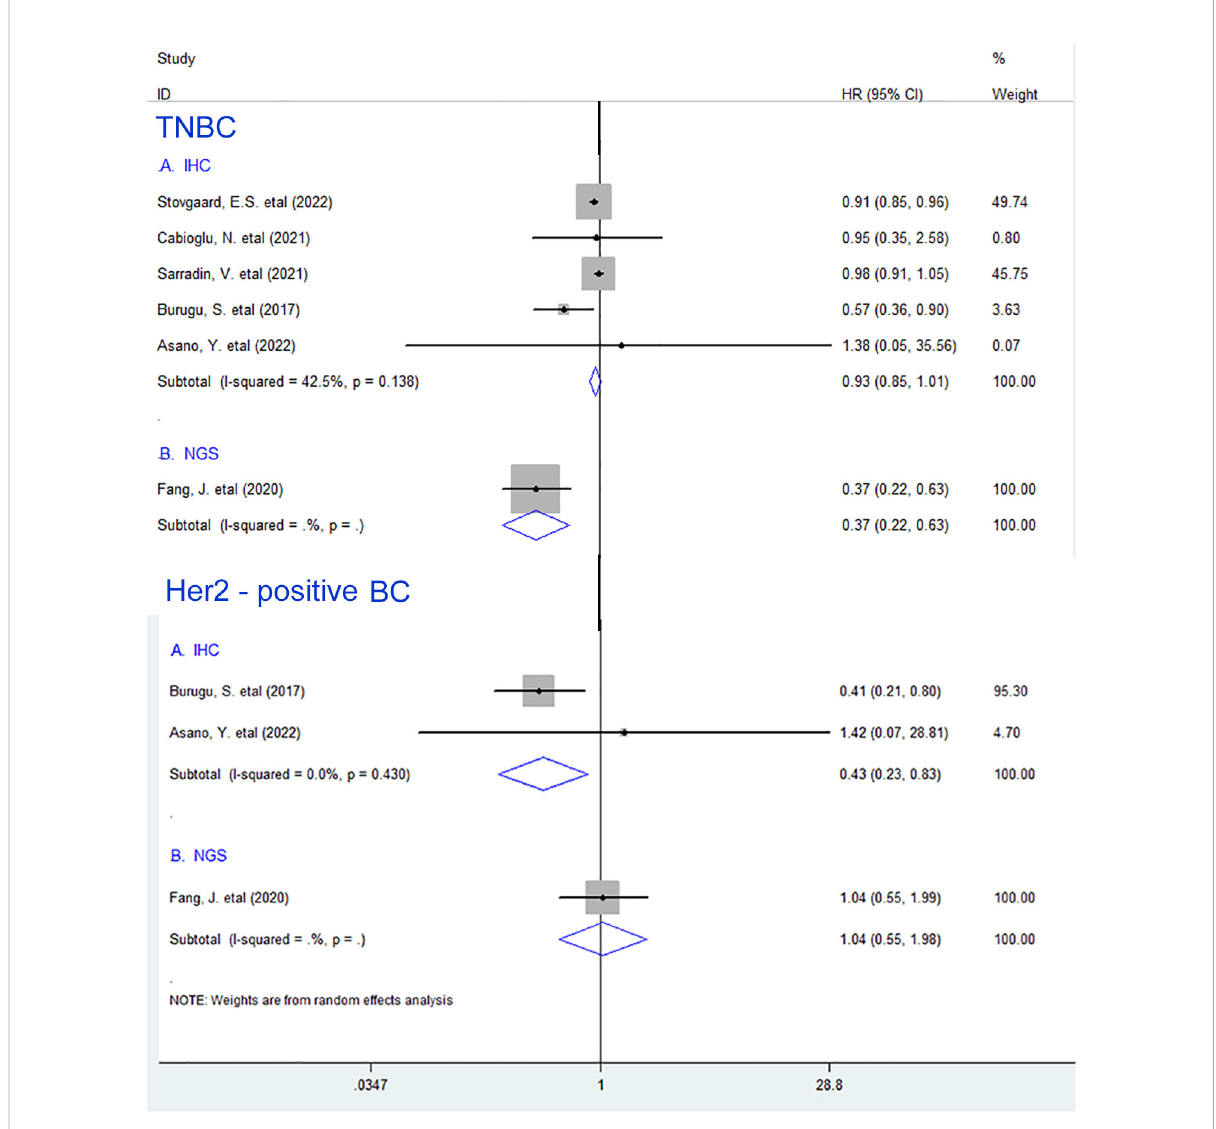
FIGURE 3 Strati fi ed analyses describing HRs of the association between LAG-3 + tumor-in fi ltrating lymphocytes and OS in TNBC and Her2-positive breast cancer according to the detection methods. TNBC, triple-negative breast cancer; IHC, immunohistochemistry; NGS, “ Next-generation ” sequencing